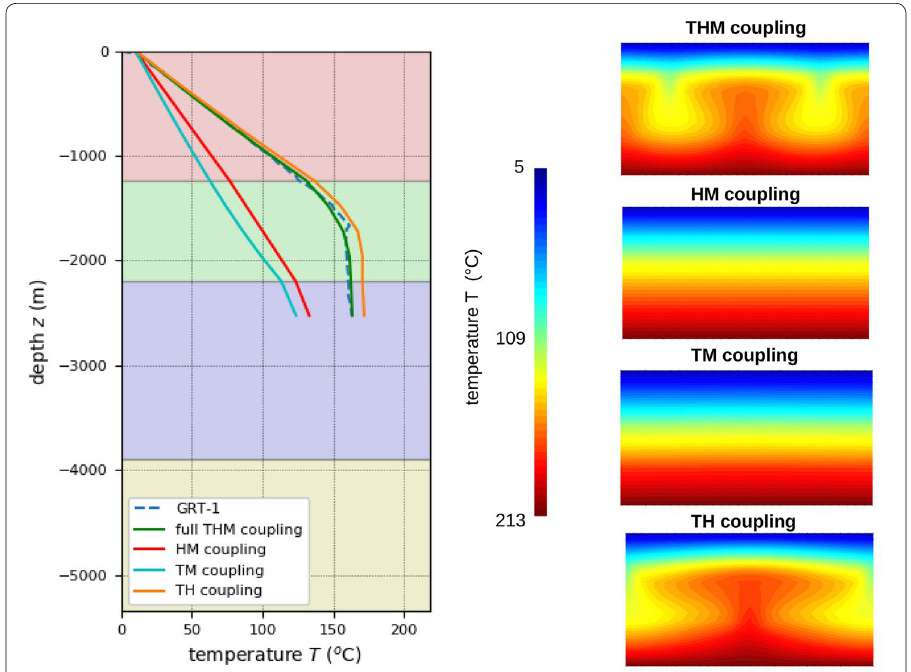
Fig. 10 Left: comparison of temperature–depth profiles for four studied cases: in green, the full coupling between thermic, hydraulic and mechanic processes is taken into account; in red, the coupling is only between hydraulics and mechanics; in blue, between thermics and mechanics; and in orange, between thermics and hydraulics. Right: associated maps of